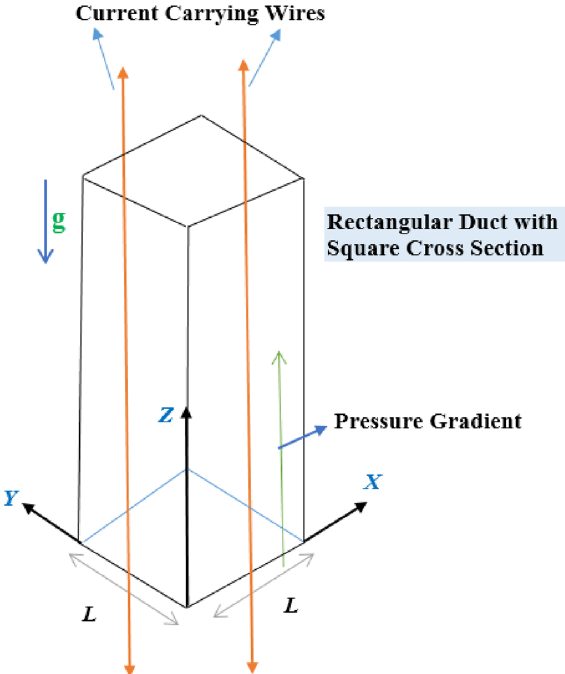
Figure 1. Physical model of the